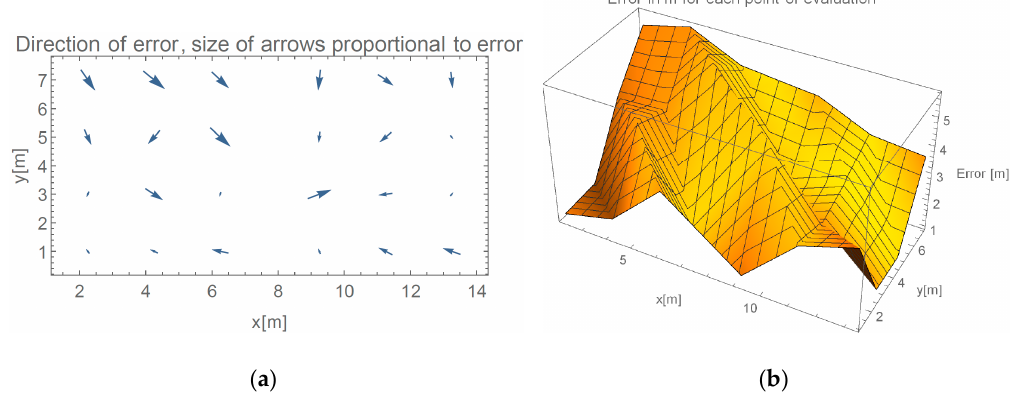
Figure 15. ( a ) Direction of errors in multi-room evaluation; and ( b ) value of localization error for each point.